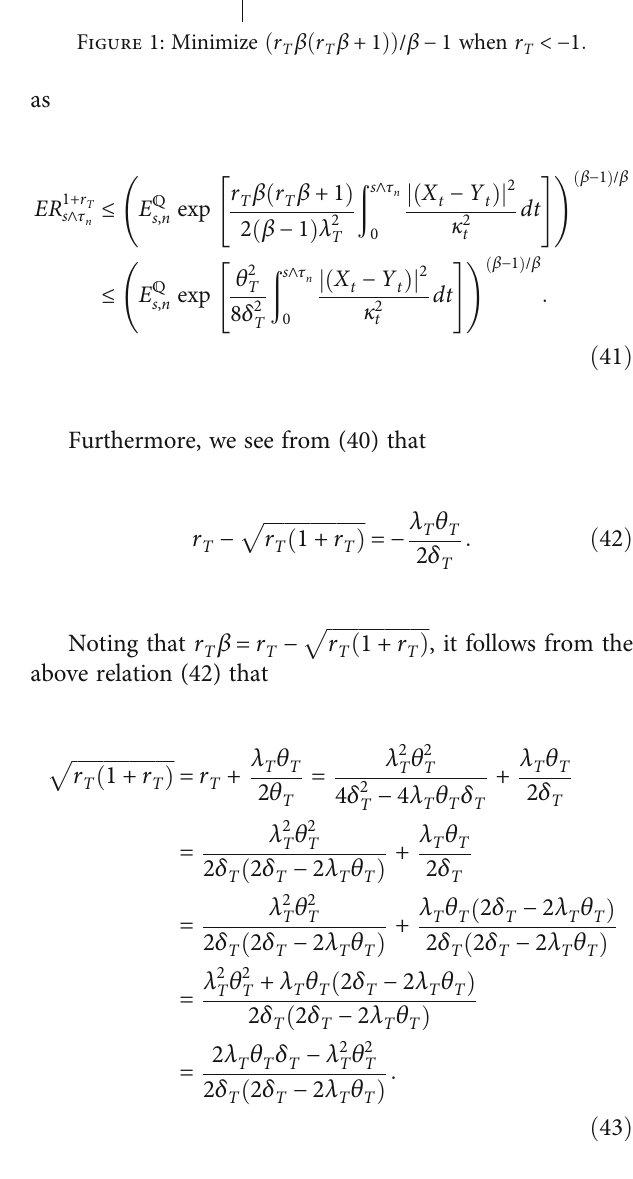
Figure 1: Minimize ð r